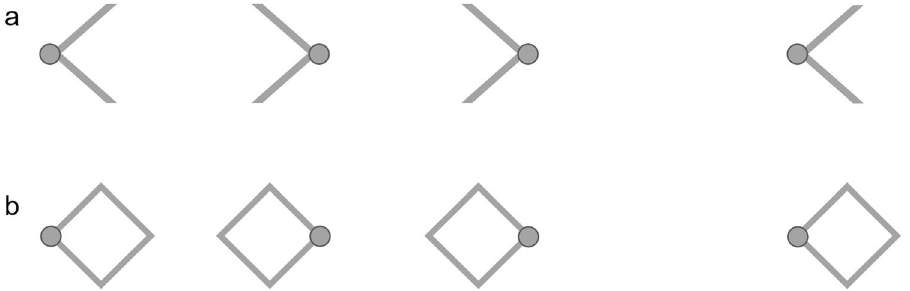
Figure 2. Traditional demonstrations of the Müller-Lyer illusion. The illusion is conventionally demonstrated using simple geometric forms including (a) arrows and (b) diamonds. In both cases, the target circles are the same distance apart in the left and right arrangements, but they appear closer together in the arrangements on the